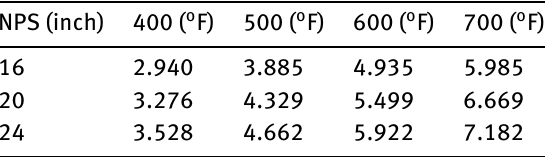
Table 2: Analytical parameter of different temperature.